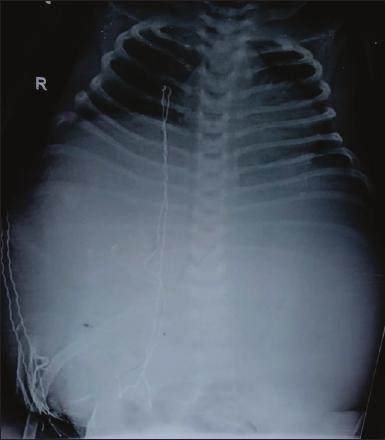
Figure 3: Histopathology showing round tumor cells arranged in small clusters and also scattered singly (H and E stain, ×40 magnification)